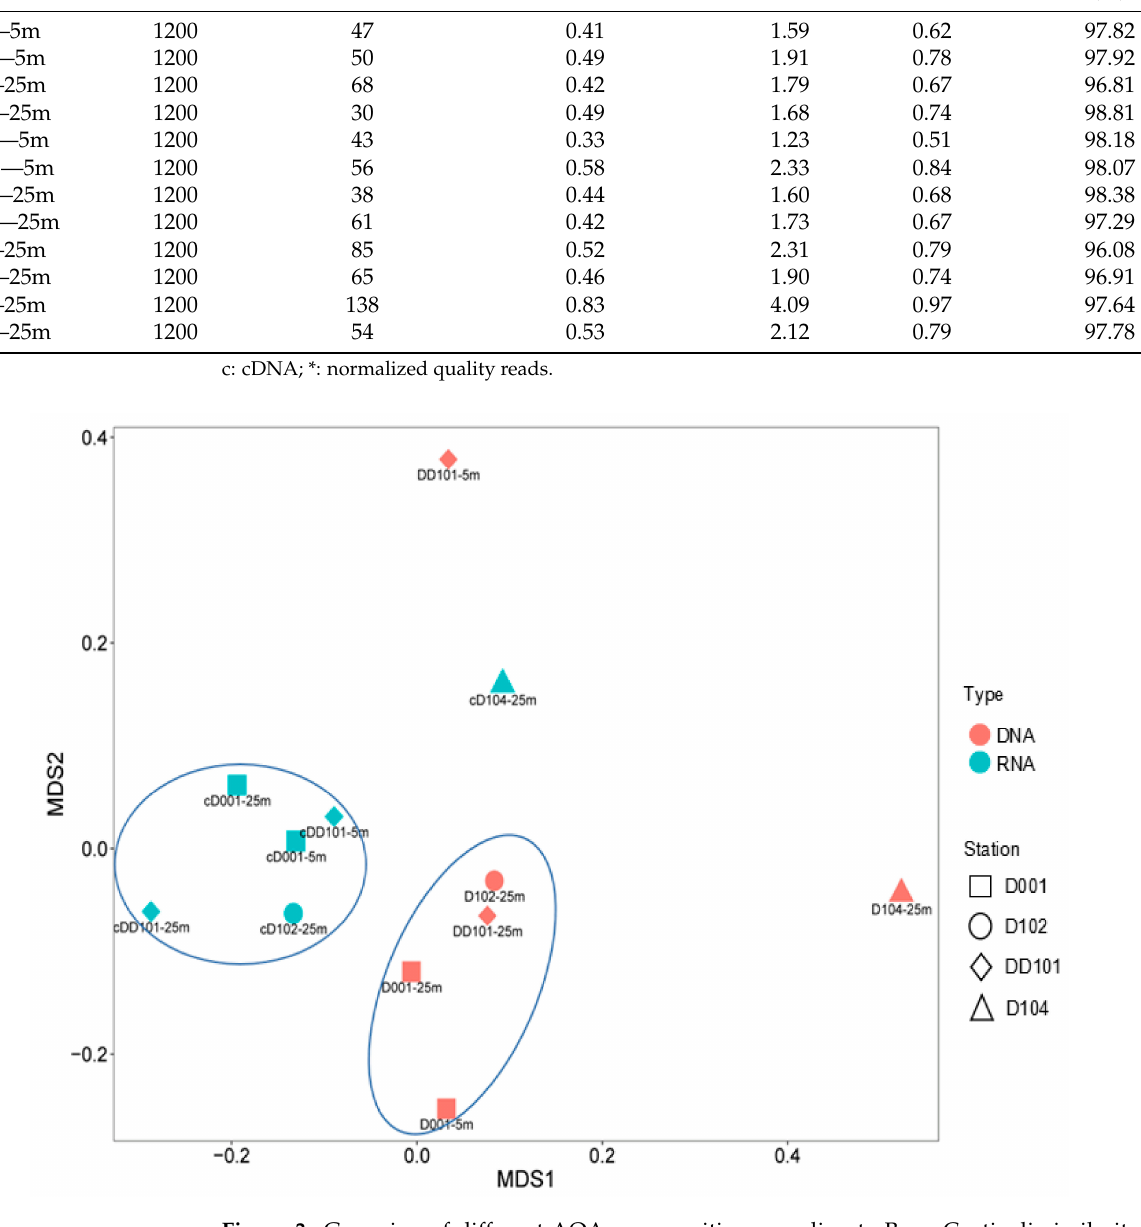
Figure 3. Grouping of different AOA communities according to Bray–Curtis dissimilarity using non-linear multidimensional scaling